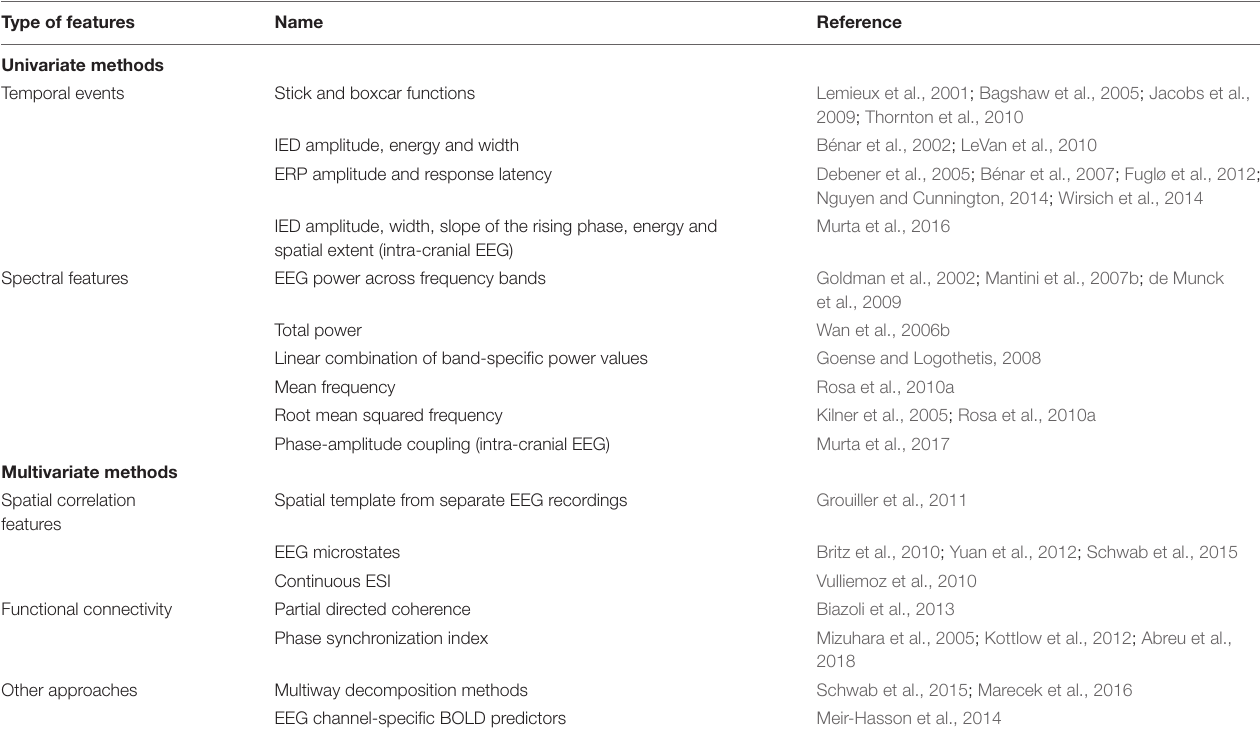
TABLE 4 | List of EEG features predictive of BOLD signal fluctuations of interest. The methods used to derive such EEG features can be roughly divided into univariate (temporal, spectral and intra-cranial features) and multivariate (spatial correlation features, functional connectivity methods and others). Type of